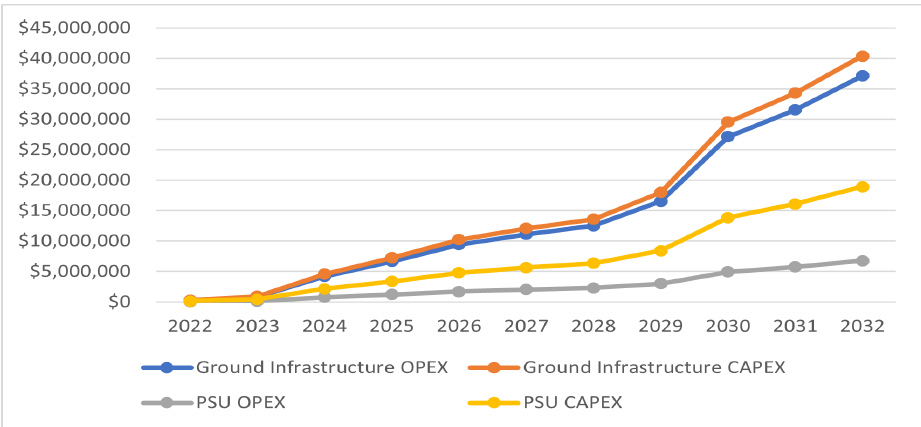
Figure 3. CAPEX-OPEX costs for AAM infrastructure in SMCO (data taken from